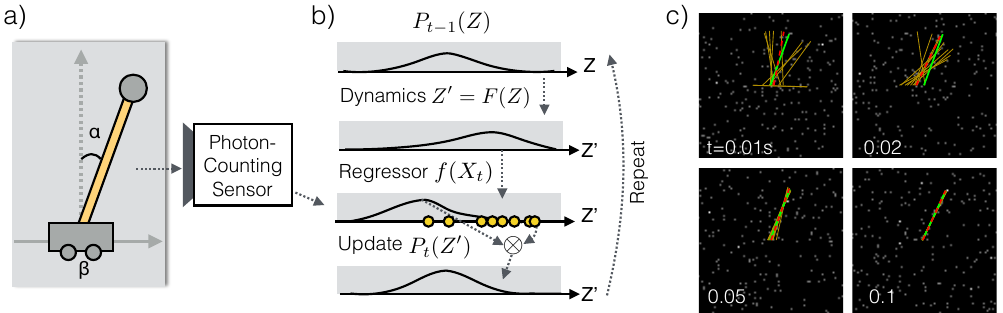
Figure 7. Low-light tracking. ( a ) An illustration of an inverted pendulum with attributes of interest α (pendulum angle) and β (cart location). The pole (yellow) is bright and everything else is dark. ( b ) Tracking algorithm (Equation (8)) iteratively updates the posterior P t ( Z ) using new evidence X t and a low-light regressor f ( X t ) . ( c ) Snapshots of a sample run at exposure times t = 0.01,0.02,0.05 and 0.1 s. The brightest pixels emit photons at λ max = 10 photons/s and the dark current (cid:101) dc = 50%. The true position of the pendulum pole is shown in green, its estimate in red dashed, and samples from the tracker’s posterior in yellow.